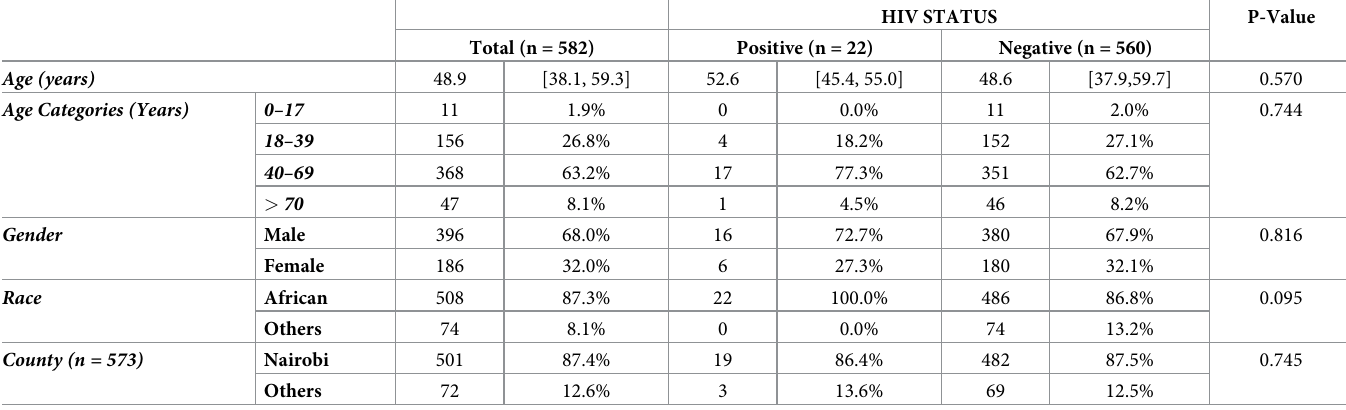
Table 1. Demographic characteristics between the HIV positive and negative